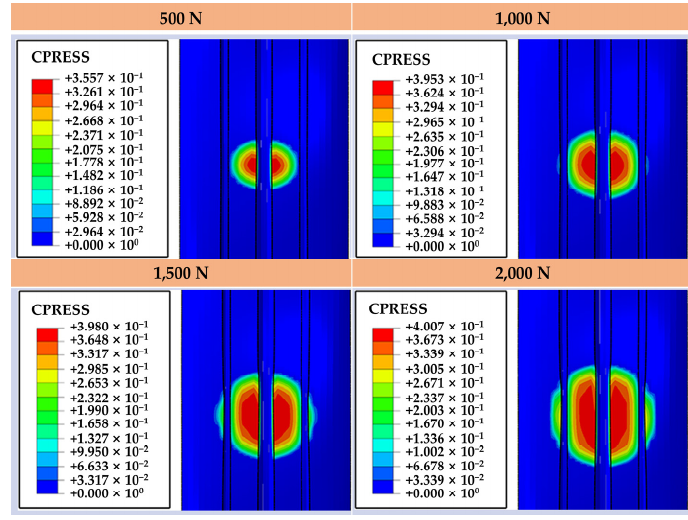
Figure 13. Contour map of tire contact pressure under different loads.